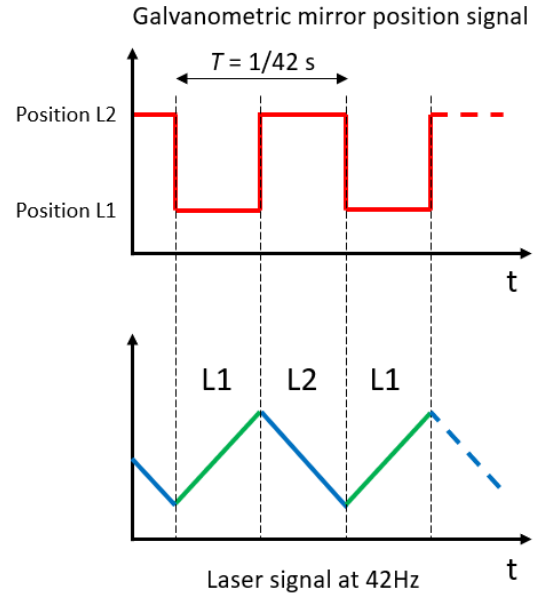
Figure 3. Schematic sketch of the synchronized galvanometric mirror position with the laser wave- length modulation